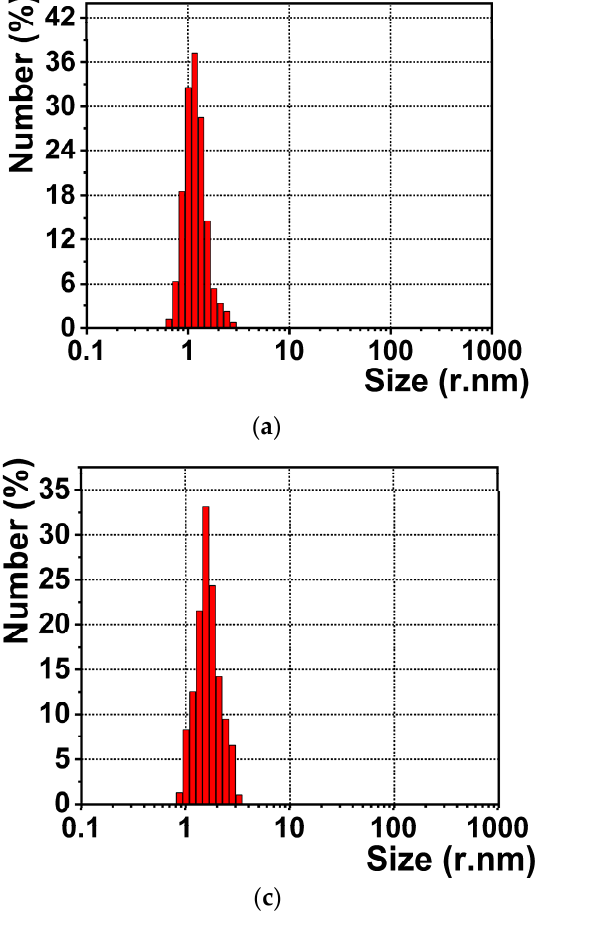
( b ) Figure 7. ( a ) Pep-CuNCs’ fluorescent intensities in the presence of (I) different metal ions and (II) different metal ions and Pb(II); ( b )The recovery test based on EDTA solution; ( n = 3). (II) (I)